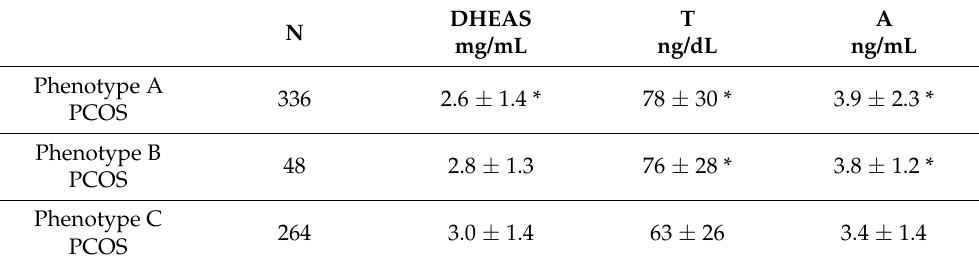
Table 2. Androgen circulating values in 648 women with polycystic ovary syndrome (PCOS), selected with age between 20 and 29 years and divided according to their